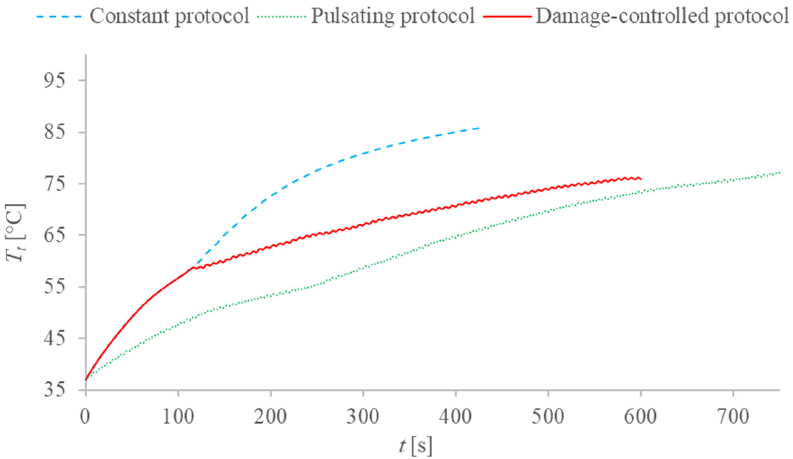
Figure 7. Tissue temperature evolution in time at the tumor rim, ( r = 1.2 cm and z = 0.0 cm) for constant protocol, pulsating protocol, and damage-controlled protocol.